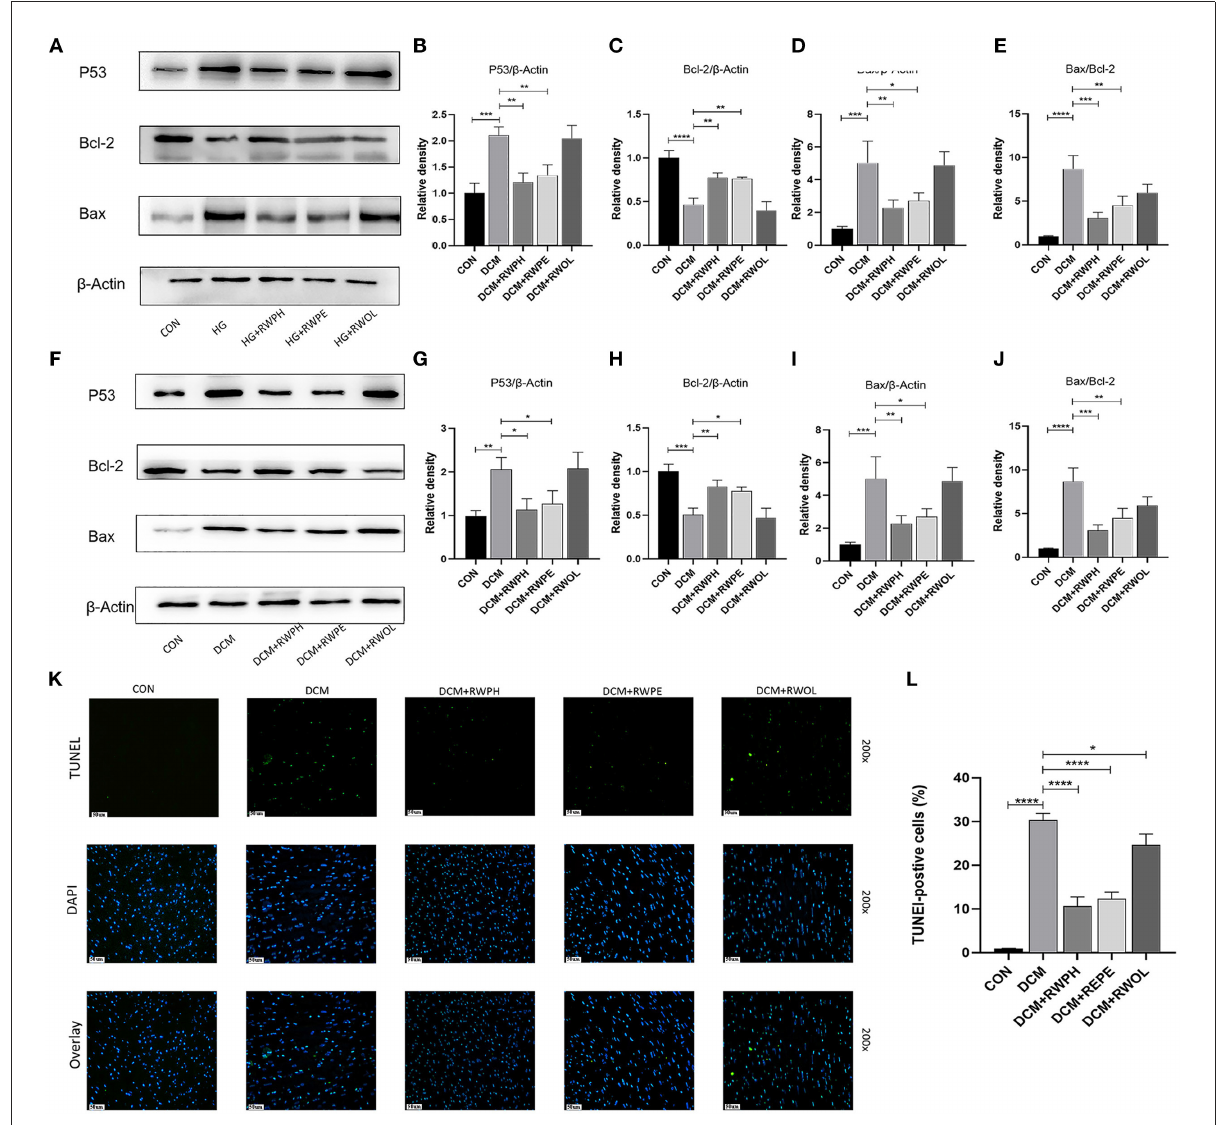
FIGURE4 RWPH and RWPE relieved apoptosis in DCM mice and high-glucose cultured H9C2 cells. (A–E) Western blot analysis of the relative protein expression of P53, Bcl-2, and Bax in H9C2 cells. (F–J) Western blot analysis of the relative protein expression of P53, Bcl-2, and Bax